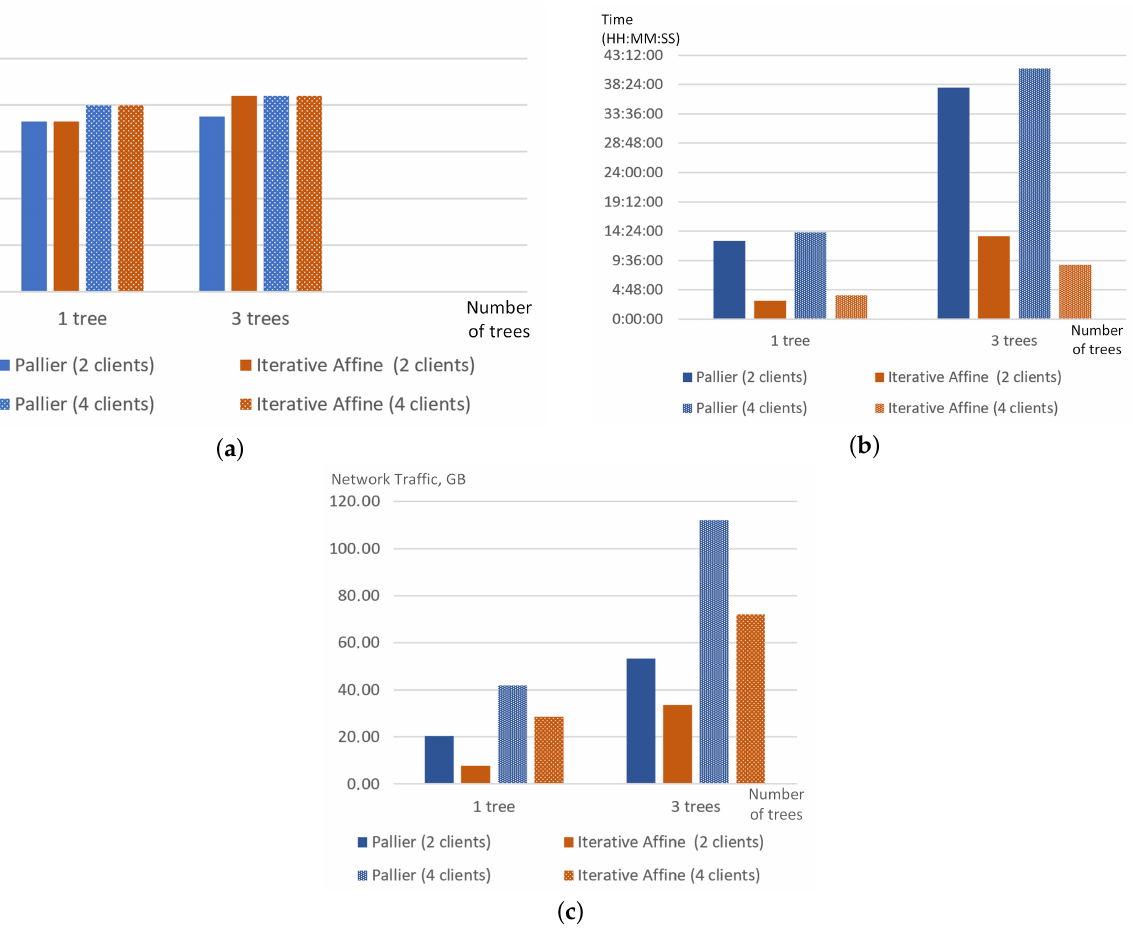
Figure 5. Comparison of different parameters of training process for Fast SecureBoost strategy with different initial settings in FATE: accuracy ( a ), training time ( b ), network traffic (GB) ( c